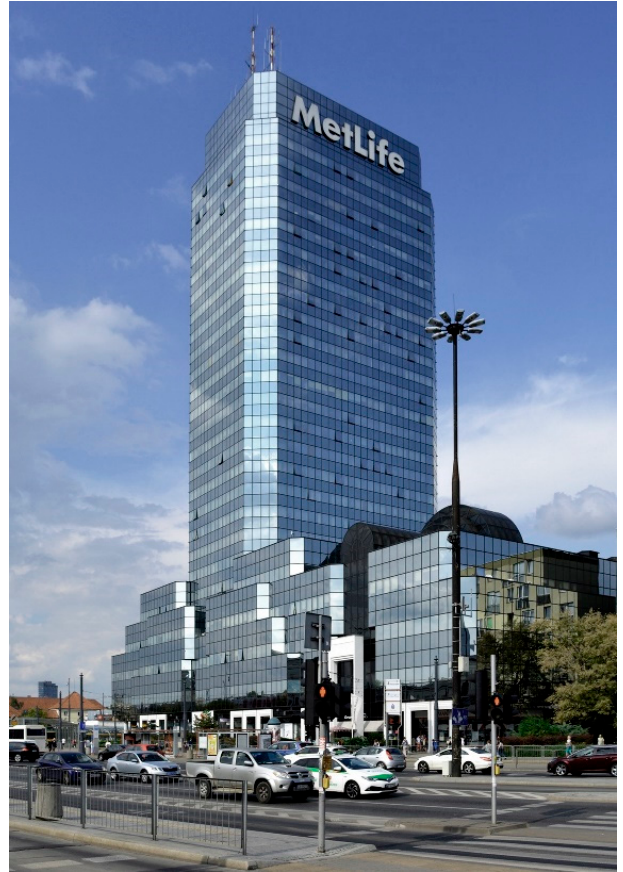
Figure 5. B łę kitny Wie ż owiec (Blue Tower)—view from Bankowy Square. Source: author’s study. Figure 5. Bł˛ekitny Wie˙zowiec (Blue Tower)—view from Bankowy Square. Source: author’s